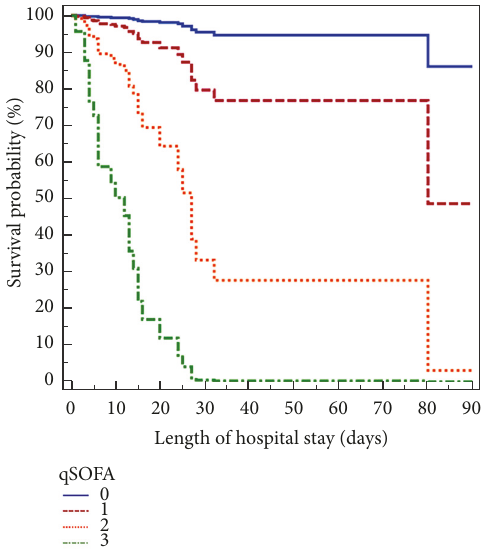
Figure 1: Comparisons of the areas under the receiver operating characteristic curves for the prediction of in-hospital mortality of the quick sequential organ failure assessment (qSOFA) and the Eastern Cooperative Oncologic Group (ECOG) scale.